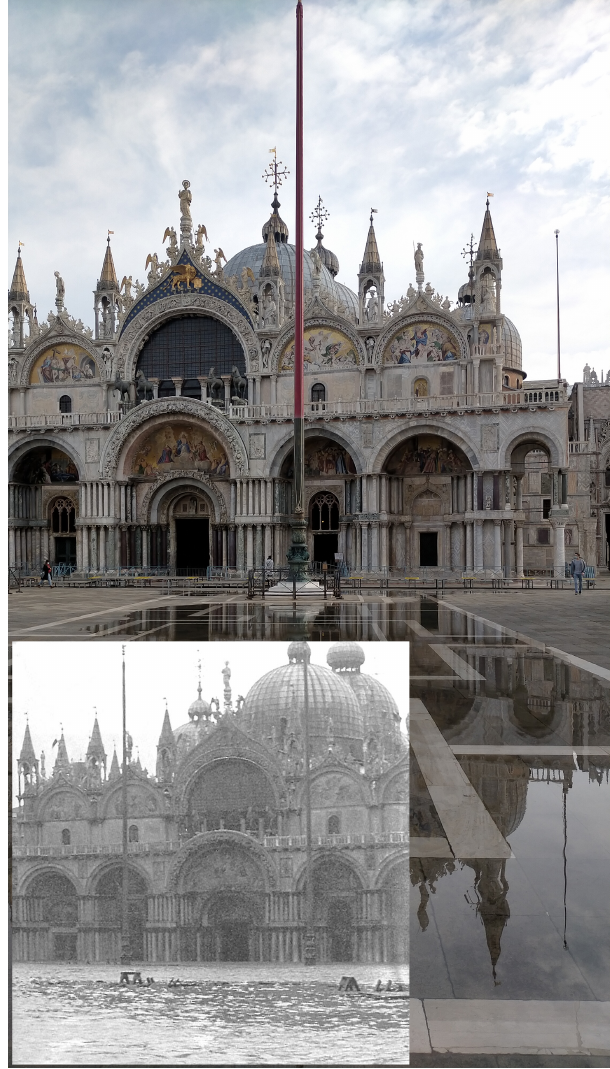
Figure 1. The present condition of St Mark’s Square during the par- tial flooding of its lowest areas (estimated water height – 80cm) and a historical picture close to the time of highest level of the 4 Novem- ber 1966 flood. The historical photograph is courtesy of Gianfranco